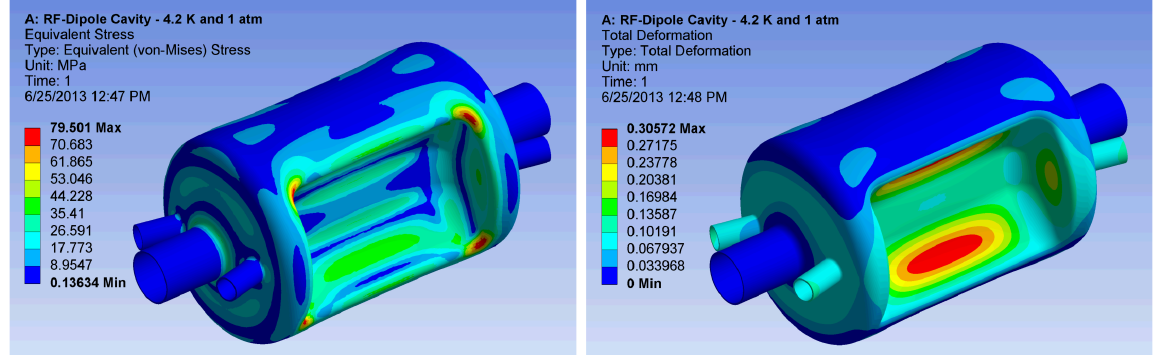
FIG. 14. Stress (left) and deformation (right) due to pressure.